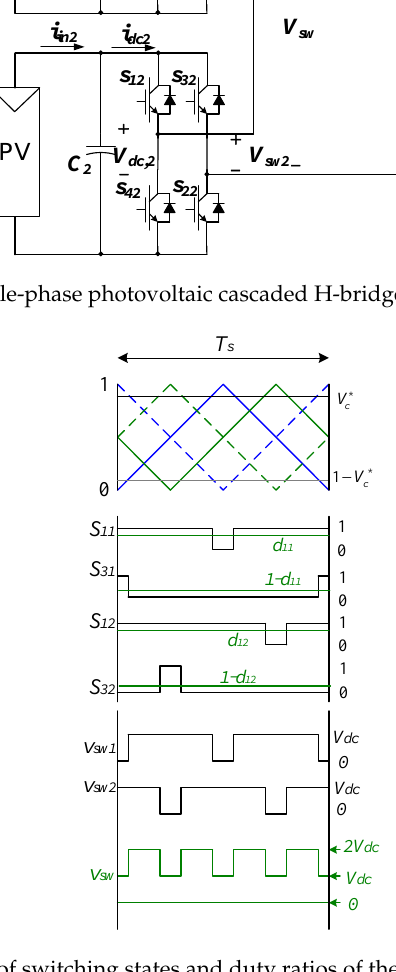
Figure 2. Relationship of switching states and duty ratios of the cascaded multilevel inverter.